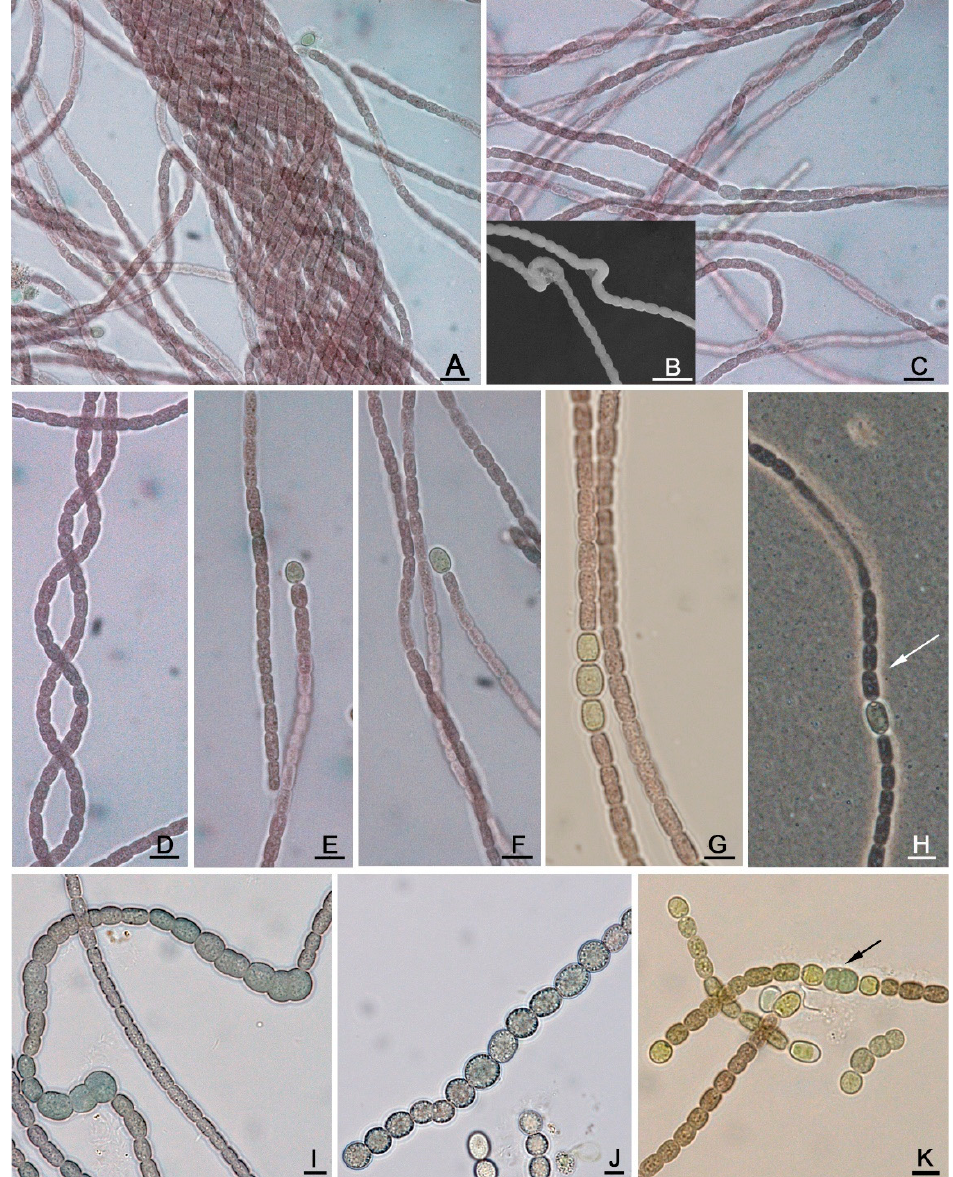
Figure 1. LM and SEM micrographs of Aliinostoc alkaliphilum . ( A ) Filaments of strain CENA513 T . ( B ) Filament morphology of CENA513 T as seen under SEM. ( C ) Filaments of CENA513 T bearing solitary intercalary heterocyte. ( D ) A single coiled filament of CENA514. ( E , F ) Solitary heterocytes of variable size and shape at terminal positions in strains CENA514 and CENA524, respectively. ( G ) Filament of CENA513 T bearing three adjacent heterocytes of variable size and shape at intercalary position. ( H ) Sheath (arrow) of CENA513 T as seen after negative staining with India ink. ( I ) Early stage of akinete development in strain CENA524. ( J ) Fully developed akinetes in strain CENA524. ( K ) Akinete germination (arrow) and hormogonia bearing terminal heterocytes CENA514. Scale